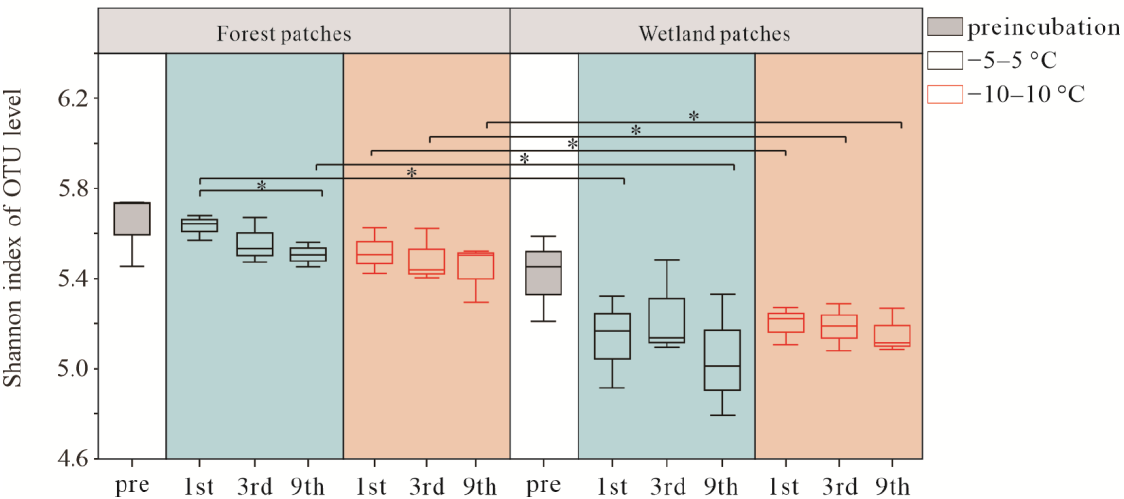
Figure 5. Bacterial alpha diversity under the different FTCs. * p < 0.05.